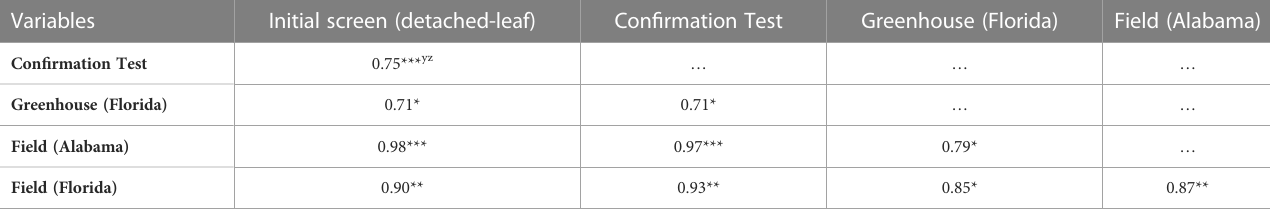
TABLE 3 Pearson correlation coef fi cients from the disease severity data to compare the similarities of initial screen, con fi rmation test, greenhouse, and fi eld evaluations.